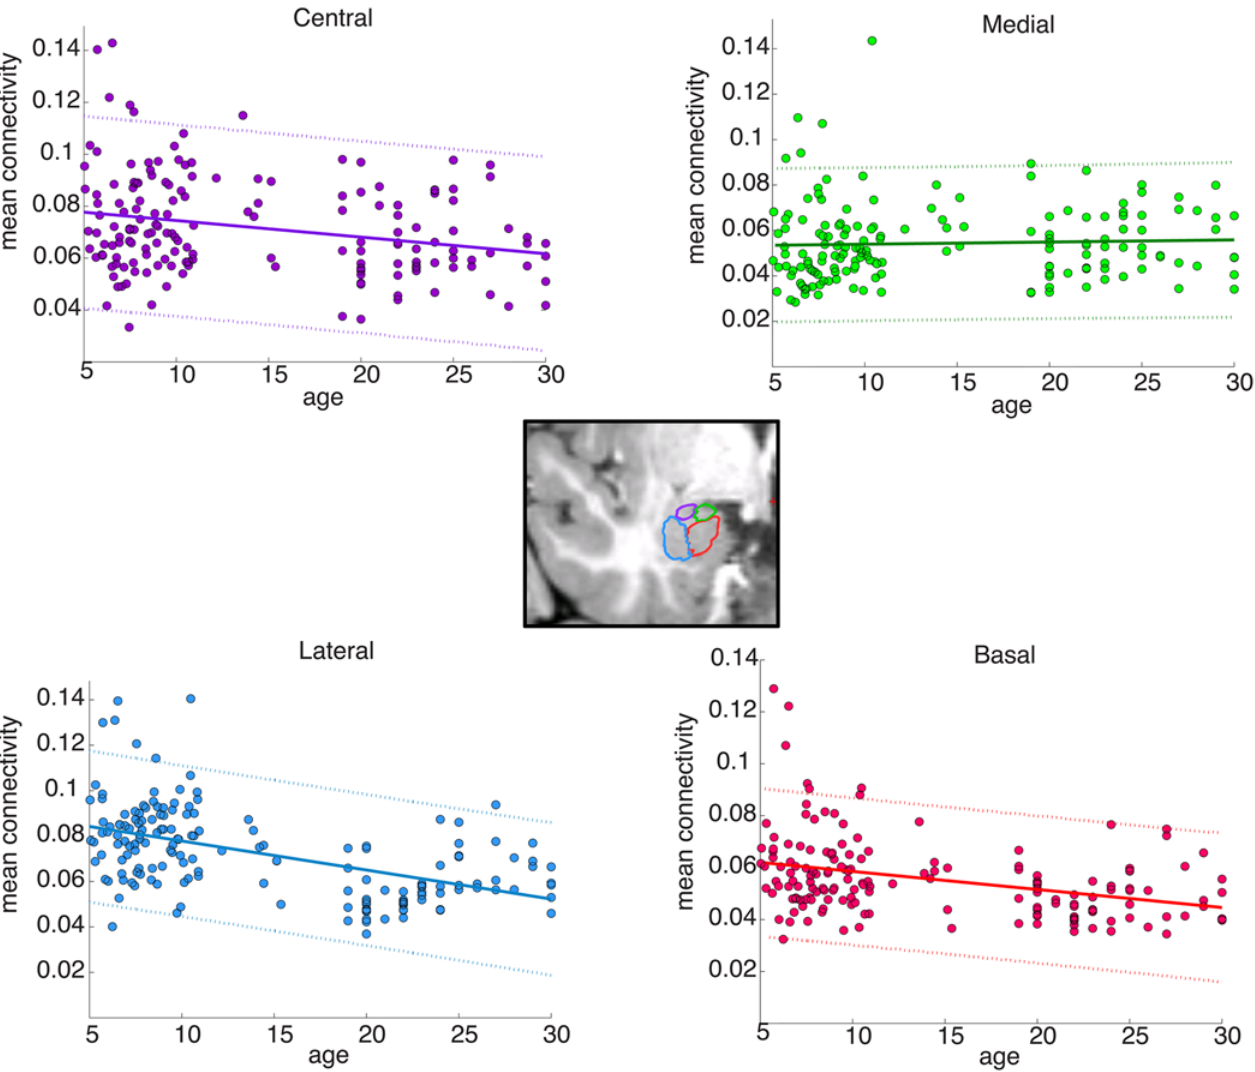
Fig 6. Correlations of age with mean connectivity for the four amygdala subregions. A probabilistic atlas of four amygdala subregions (illustrated in the center; coronal slice) was used to extract mean connectivity values from each subregion bilaterally per subject and plotted by age. While connectivity with the basal, lateral, and central subregions were significantly correlated with age, connectivity with the medial amygdala showed no significant change with